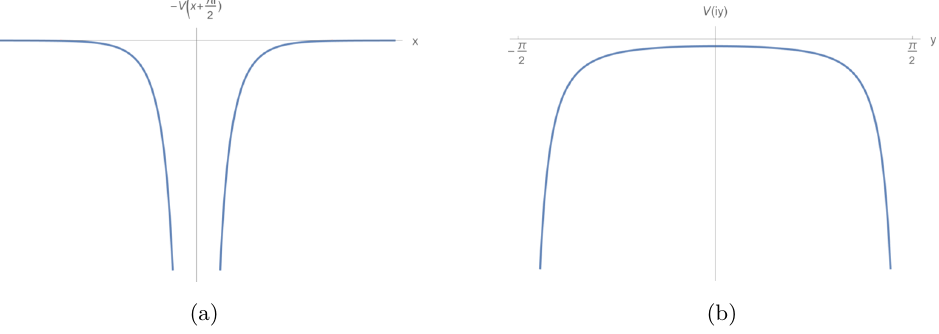
Figure 4. Singular potentials. On the slices Im( r ) = π experienced by the particle falls to −∞ at the singular